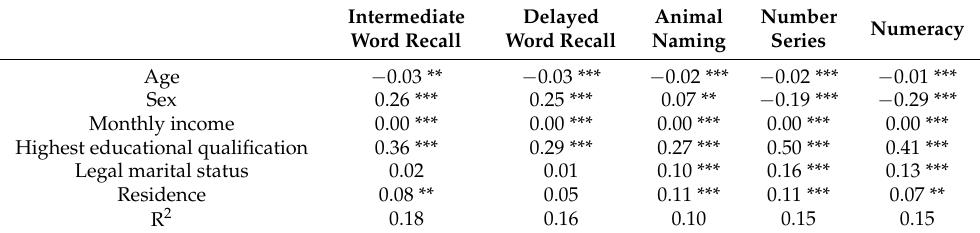
Table 2. The estimates ( b ) of linear models trained based on demographic